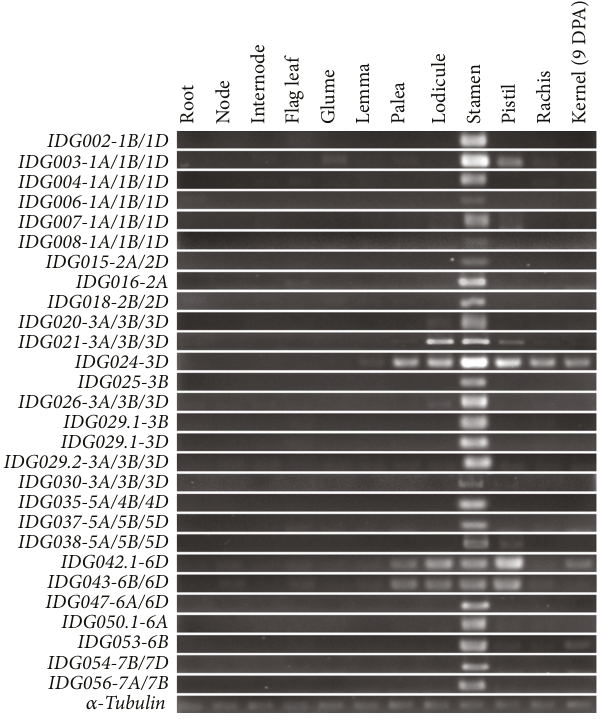
Figure 2: Expression of a selected set of identi fi ed genes in di ff erent tissues. The tissues used included kernel 9th day postanthesis, root, node, internode, fl ag leaf, glume, lemma, palea, lodicule, stamen, pistil, and rachis at the heading stage of common wheat landrace “ Wangshuibai.